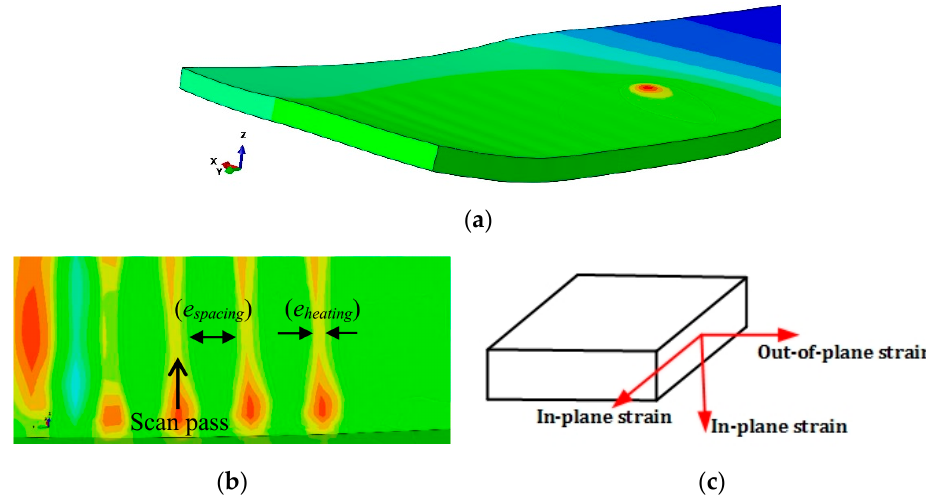
Figure 4. ( a ) Simulation of the deformed sample; ( b ) definition of e heating and e spacing in the strain field; and ( c ) definition of the in-plane and out-of-plane strains.